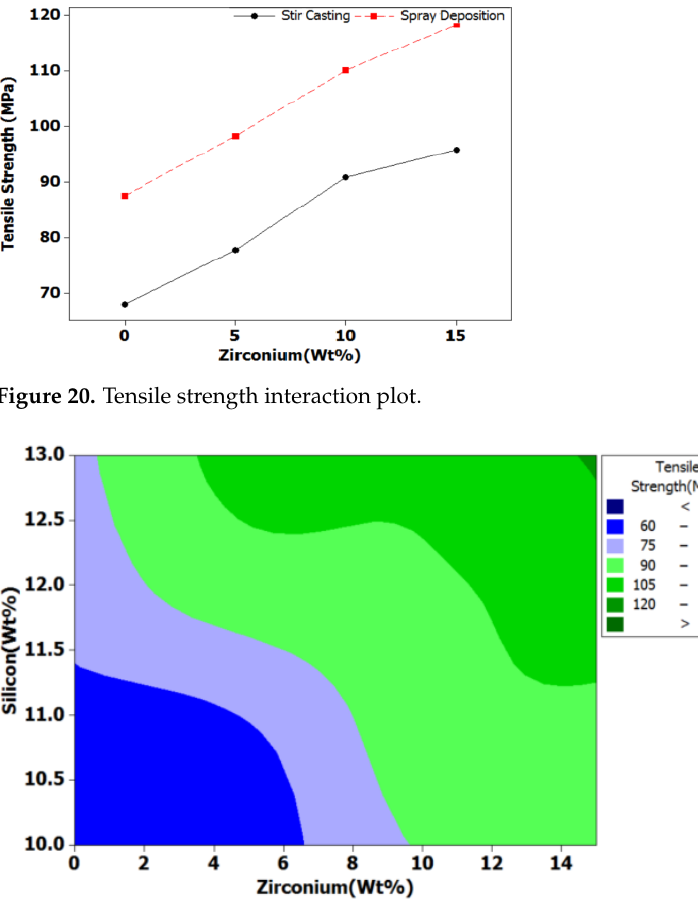
Figure 21. Tensile strength contour plot at zirconium dioxide–silicon planes.